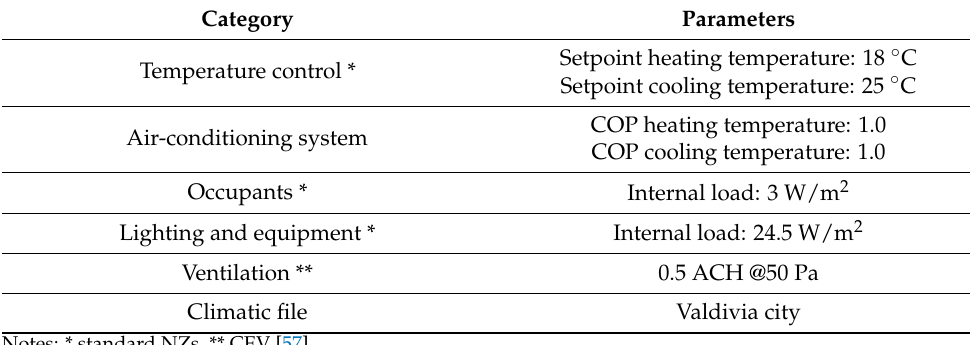
Table 5. Modelling conditions for thermal energy simulations.